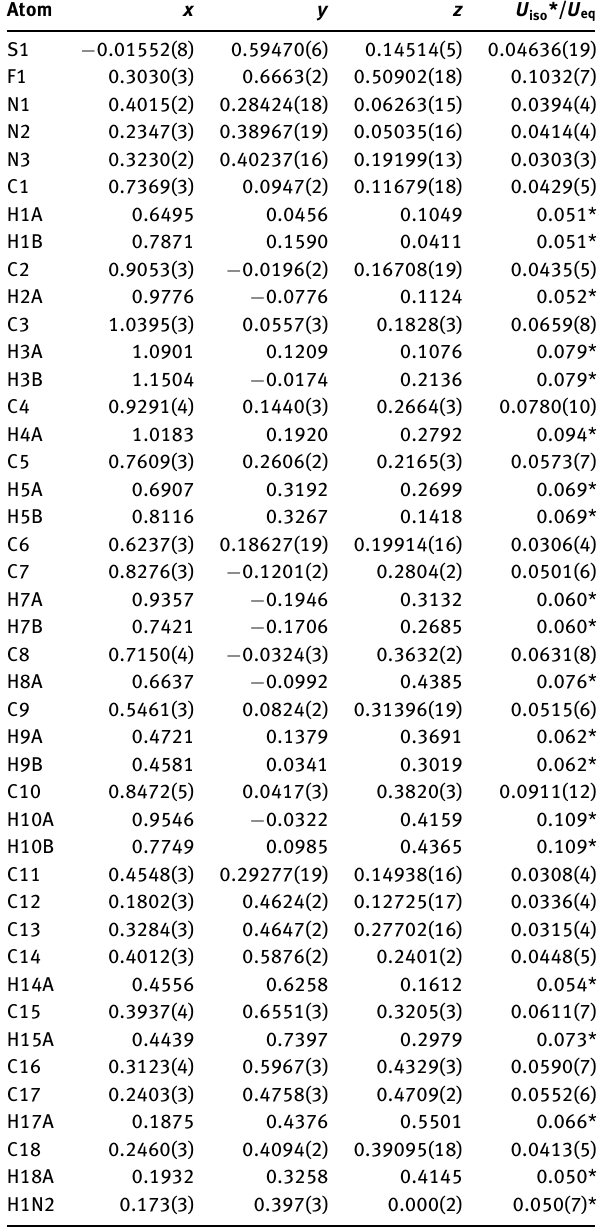
Table 2: Fractional atomic coordinates and isotropic or equivalent isotropic displacement parameters (Å 2